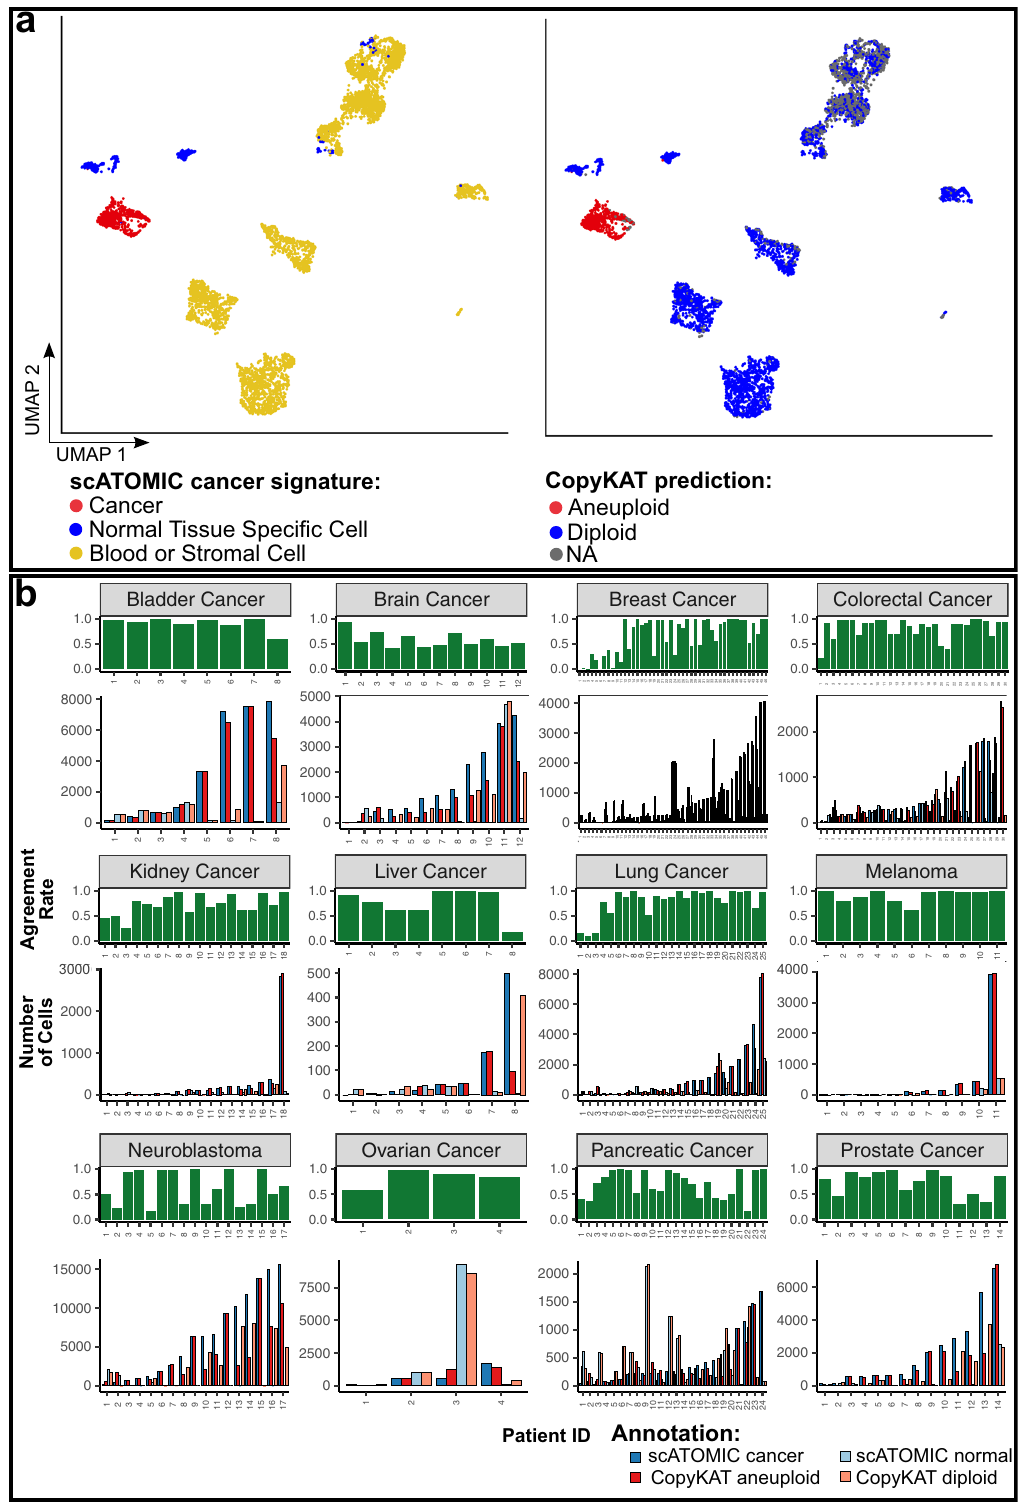
Fig.3|scATOMICeffectivelydistinguishesbetweenmalignantcellsandnormal tissue speci fi c cells. a scATOMIC predictions and inferred ploidy in breast cancer patient CID4066 21 . Cells are coloured by scATOMIC predictions and copy number variation (CNV)-based inferred ploidy. scATOMIC-predicted malignant cells are inferred as aneuploid cells while normal tissue cells are inferred as diploid. b Comparison of scATOMIC cancer predictions and inferred ploidy statues across the training-independent, external validation datasets. Blue bars represent the